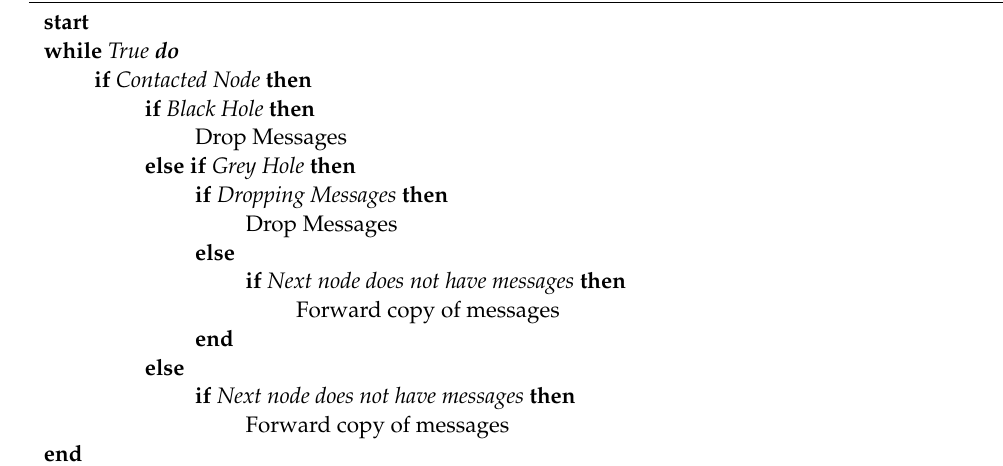
Algorithm 1. Black and Grey Hole Epidemic Router